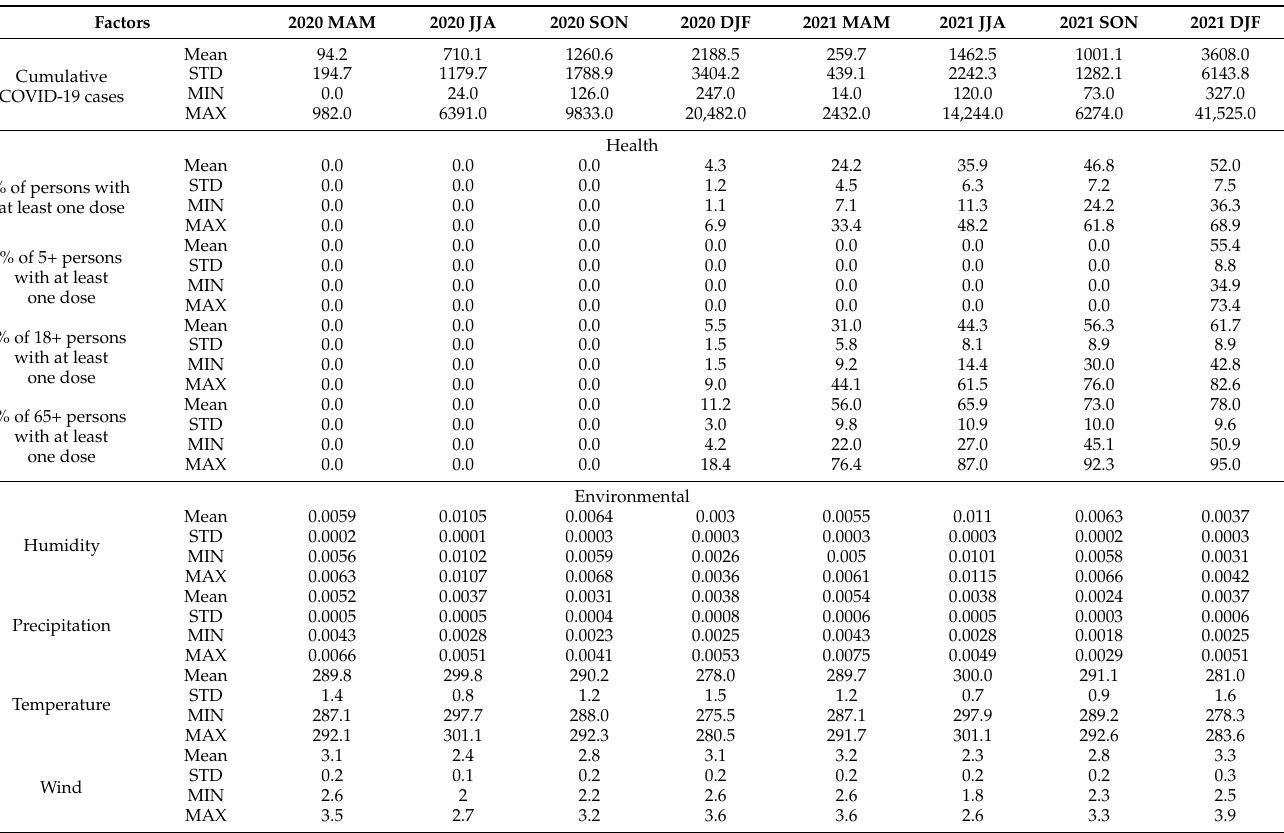
Table 4. Statistical summary for the COVID-19, health, and environmental factors with the seasonal temporal